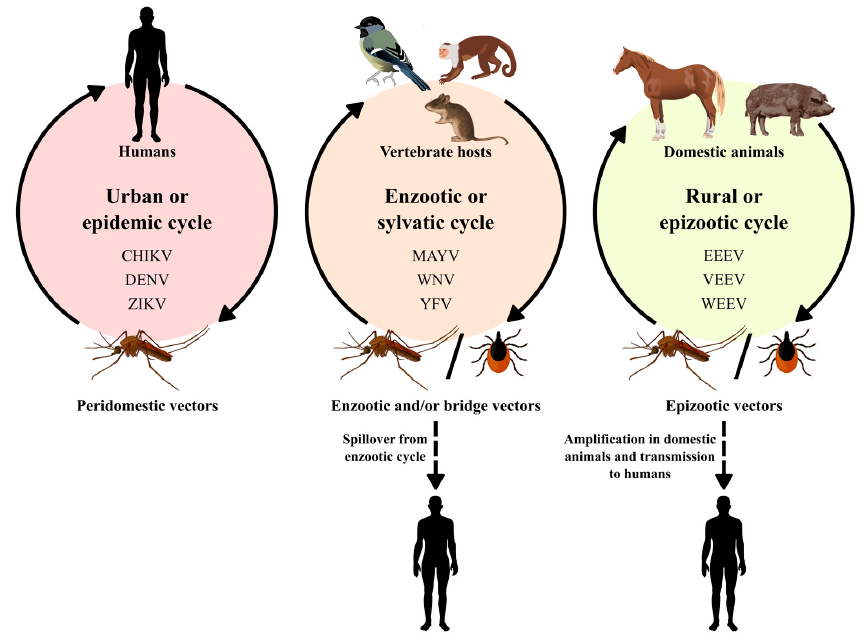
Figure 1. Alphaviruses and fl aviviruses transmission cycles.